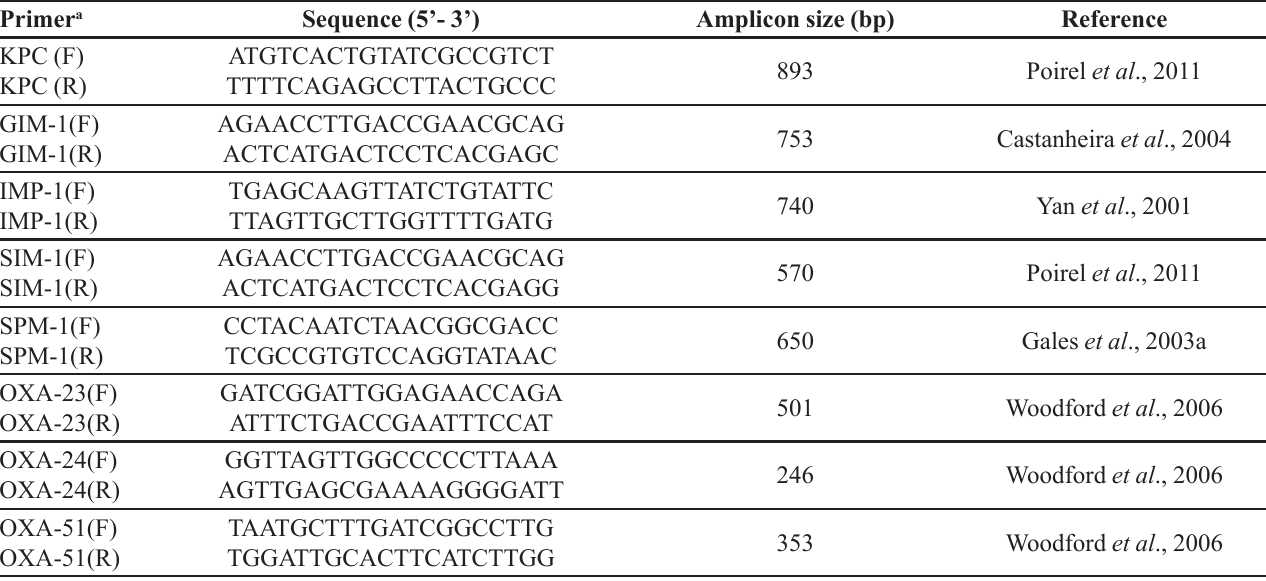
TABLE I - Oligonucleotides used in the PCR reactions Primer a